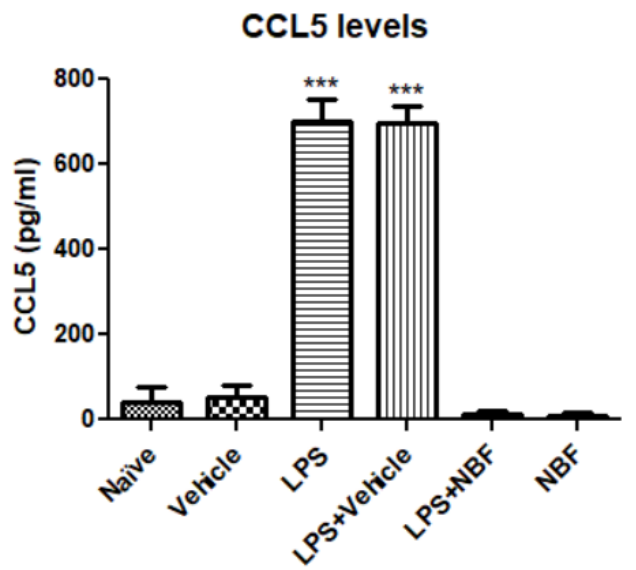
Figure 3. NBF downregulates the release of CCL5 (RANTES) in RAW264.7 macrophages following LPS stimulation. RAW 264.7 macrophages were exposed to 20 ng/mL LPS and simultaneously with the NBF, 20 µg/mL. CCL5 levels were measured (pg/mL) using standard calibration curves and are presented as the mean ± SD. Four replicates in each group ( n = 4). ANOVA followed by Bonferroni’s post hoc test was performed. *** p < 0.001 compared to all other groups.